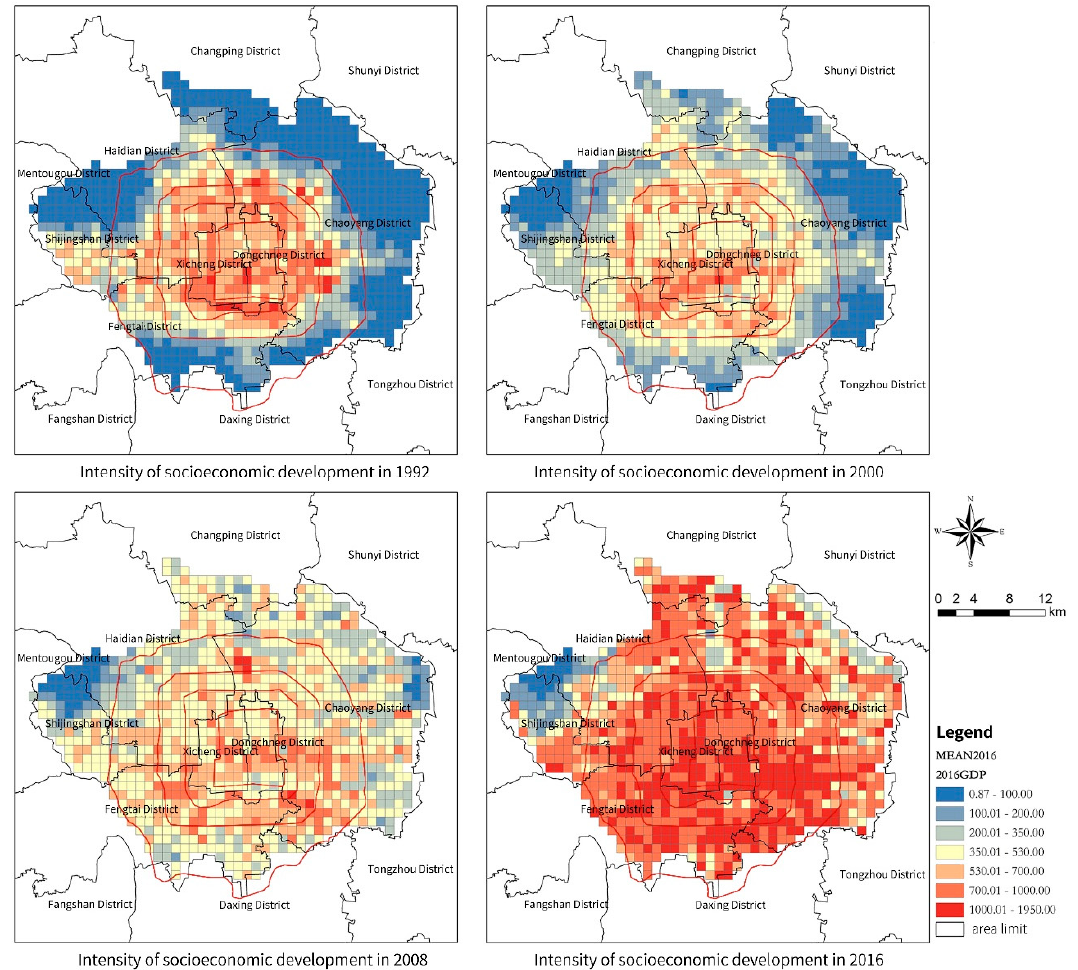
Figure 4. Urbanization intensity (light inversion) in central Beijing in the years 1992, 2000, 2008, and 2016.